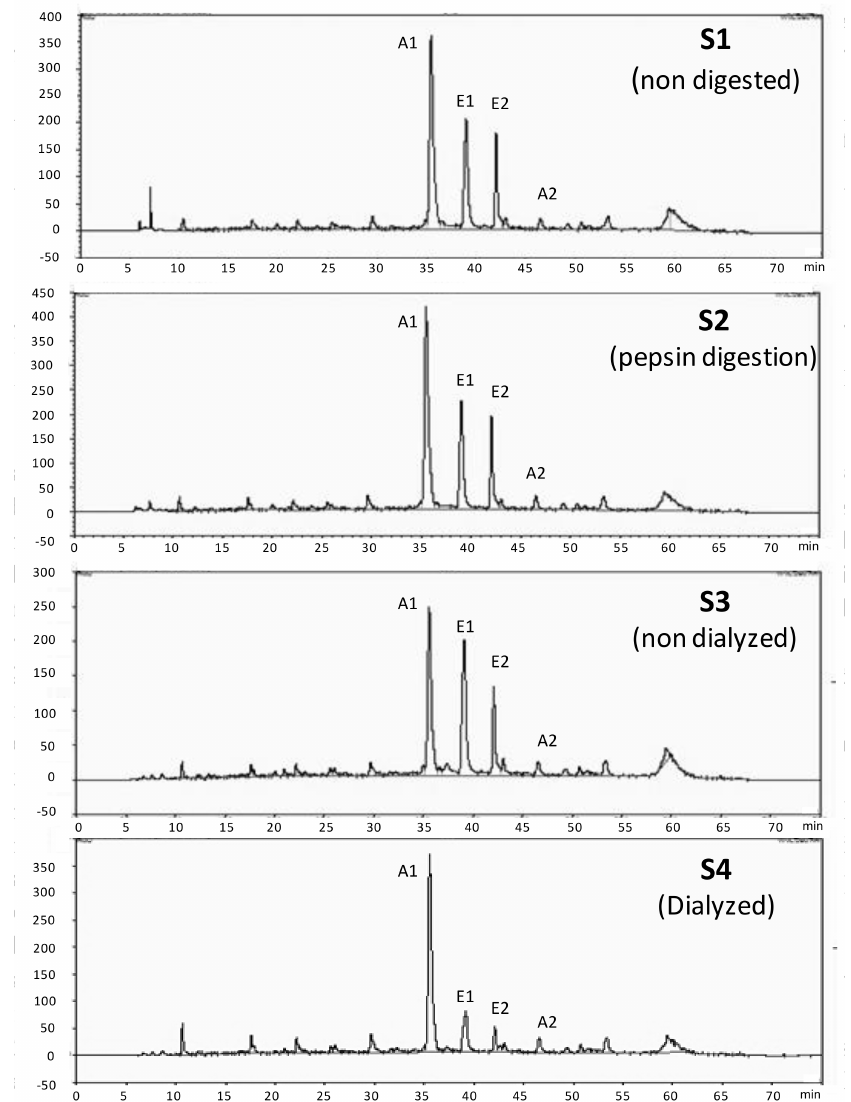
Figure 1. HPLC Chromatogram of the digested blackberry juice polyphenols. A1: cyanidin-3-glucoside, A2: cyanidin-3-malonyl glucoside, E1: lambertianin C, E2: sanguiin H-6. (Corresponding tentative identification of peaks according to Mertz et al.